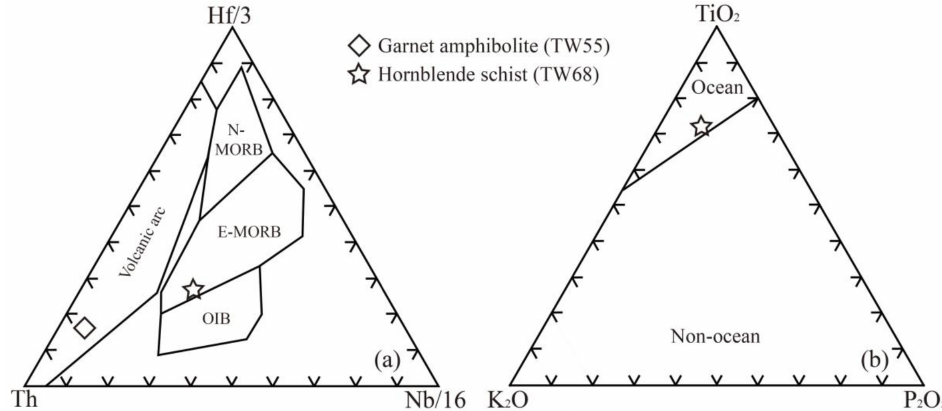
Figure 7. ( a ) Hf/3-Th-Nb/16 diagram (after [66]). ( b ) TiO 2 -K 2 O-P 2 O 5 diagram (after